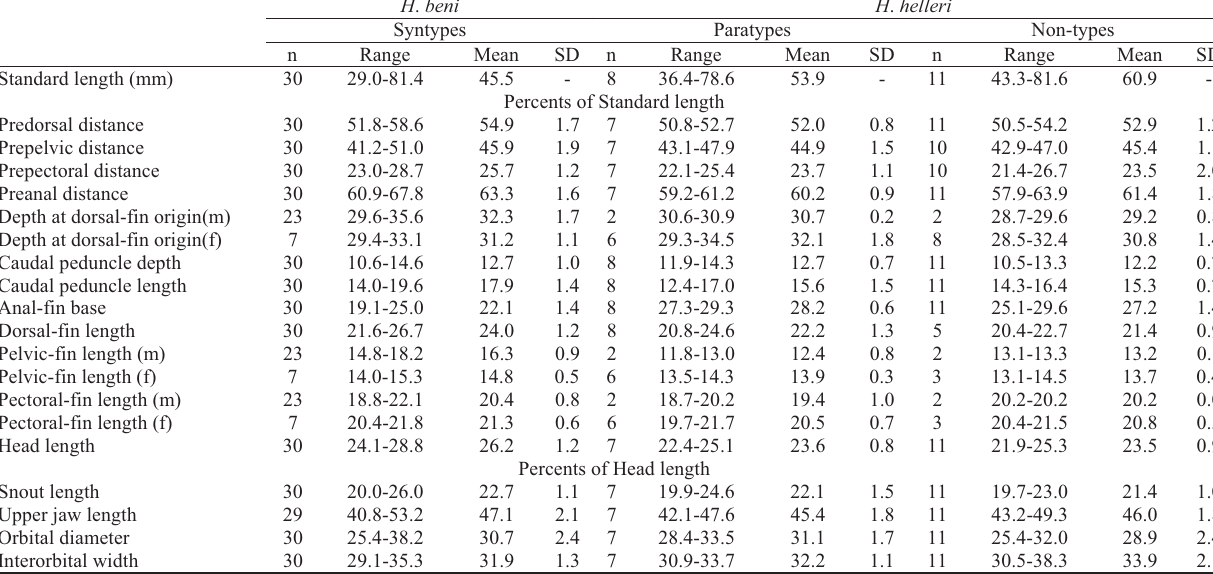
Table 1. Morphometric data of syntypes of Hemibrycon beni (CAS 44333, 44334; USNM 117543) from río Beni basin, Espia, La Paz, Bolivia, and paratypes of Hemibrycon helleri (CAS 44354; FMNH 58439), and non-types from río Urubamba basin (ANSP